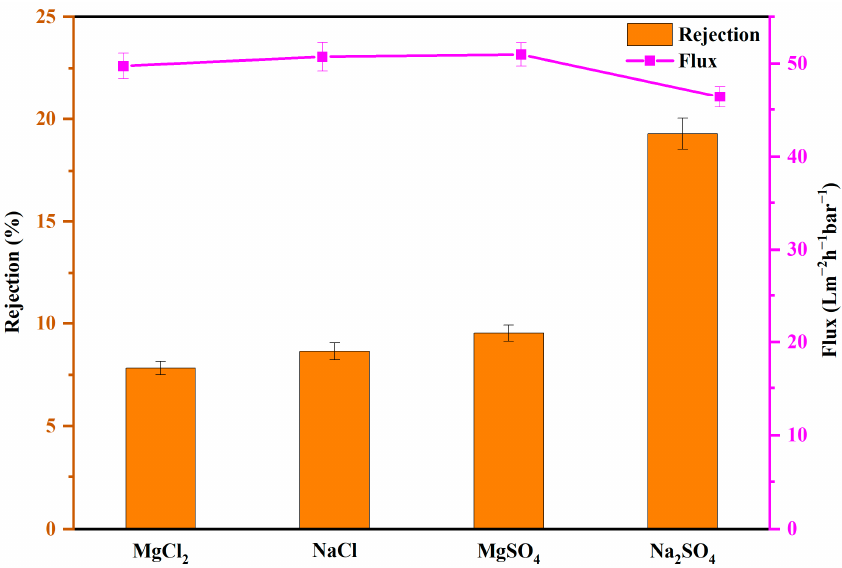
Figure 11. The rejection of PES–DPS–1 for various inorganic salts (the concentration was 2 g·L − 1 ). In addition, the removal rate and the water flux of the PES–DPS–1 membrane for the tested dyes with different molecular weights are shown in Figure 12. PES–DPS–1 membrane exhibited high rejections toward CR (98.5%), G-250 (98.8%), DB71 (99.1%), and DR80 (99.6%), with relatively low rejection toward CV (79.9%). The negative dye mole- cules (CR, G-250, DB71, and DR80) were repelled by the negatively charged PES–DPS–1 membrane surface. In contrary, the negatively charged PES-DPS-1 surface exhibits a pow- erful electrostatic adsorption e ff ect on positively charged CV molecules, thereby dimin- ishing the negative charge density present on the surface of the membrane. Therefore, the rejection of CR, G-250, DB71, and DR80 was higher than CV. Interestingly, both CR (696.66) and G-250 (825.97) dyes have molecular weights smaller than the MWCO (843) of the PES-DPS membrane; nevertheless, the membrane rejected both dyes with high e ffi - ciency. However, previous research has indicated that dyes with ring structures do not exist as individual dye molecules in a solution, but instead have a tendency to aggregate and form larger molecular clusters [29]. Therefore, pore-size characterization by dye mol-